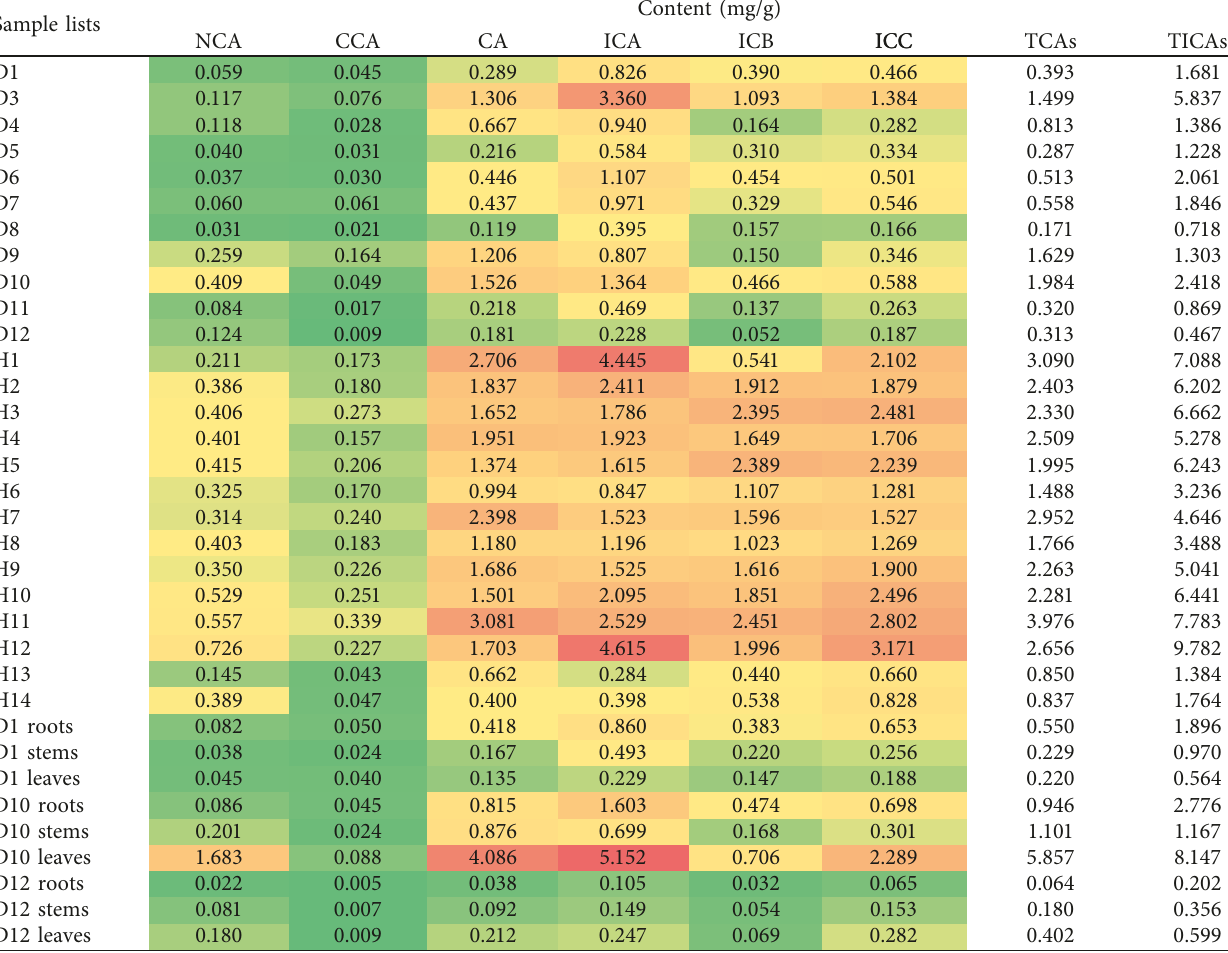
Table 5: Heatmap of six CA contents in M. chamomilla samples ( n � 2). Sample lists